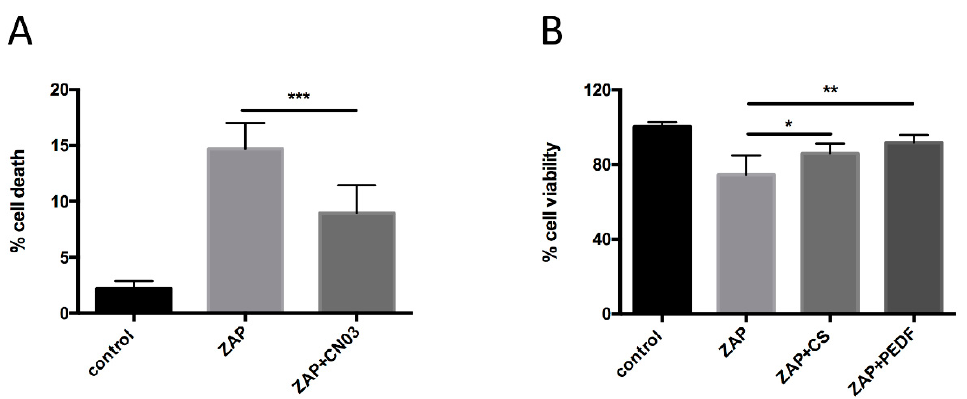
Figure 5. Validation of the in vitro model for drug screening. ( A ) A TUNEL assay was used to determine the percentage of cell death in 661W-A11. ( B ) Cell viability was assessed by MTT assay. The values of cells treated with the vehicle (DMSO, control) were set as 100% cell viability. ZAP: cells treated with 400 µ M zaprinast; ZAP+CN03 or CS or PEDF: cells were pretreated with 50 µ M CN03 or 20 µ M calpastatin peptide (CS) or 10 nM PEDF for 2 h before being stressed with 400 µ M zaprinast in the presence of the neuroprotective compounds. Statistical comparison: Student’s unpaired two-tailed t -test; * p < 0.05, ** p < 0.01, *** p < 0.001.